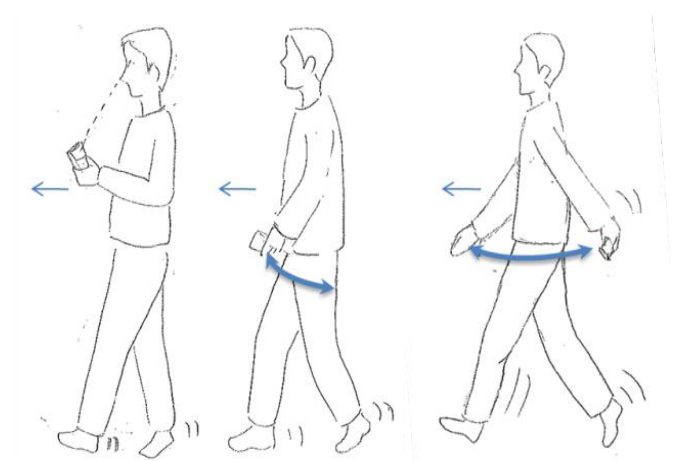
Figure 2. W-series (left: WH, middle: WS, and right: